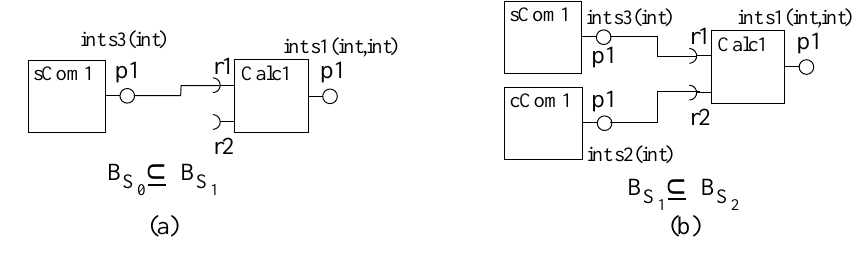
Figure 16. A basic-cs system in ArchJava: ( a ) First system and ( b ) Second